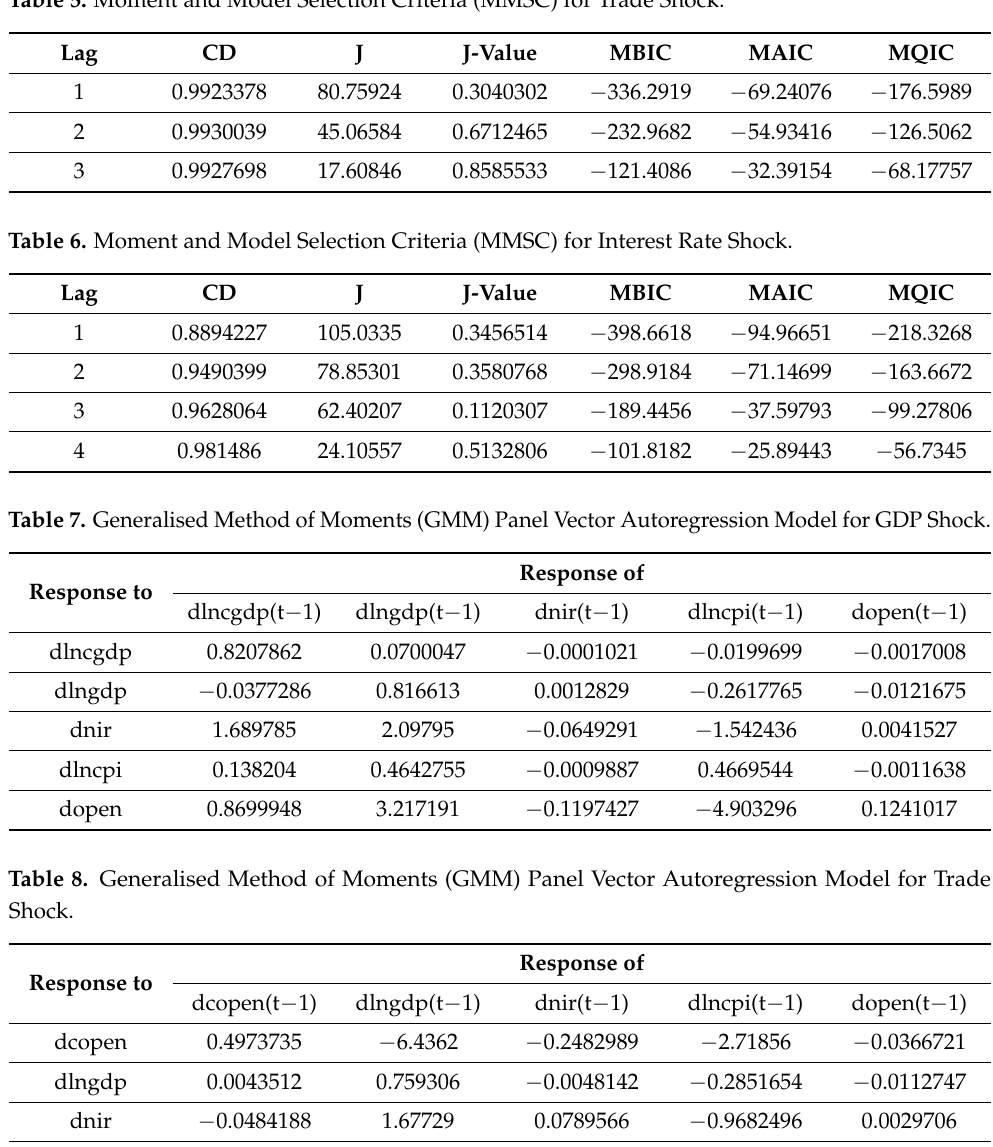
Table 5. Moment and Model Selection Criteria (MMSC) for Trade Shock.